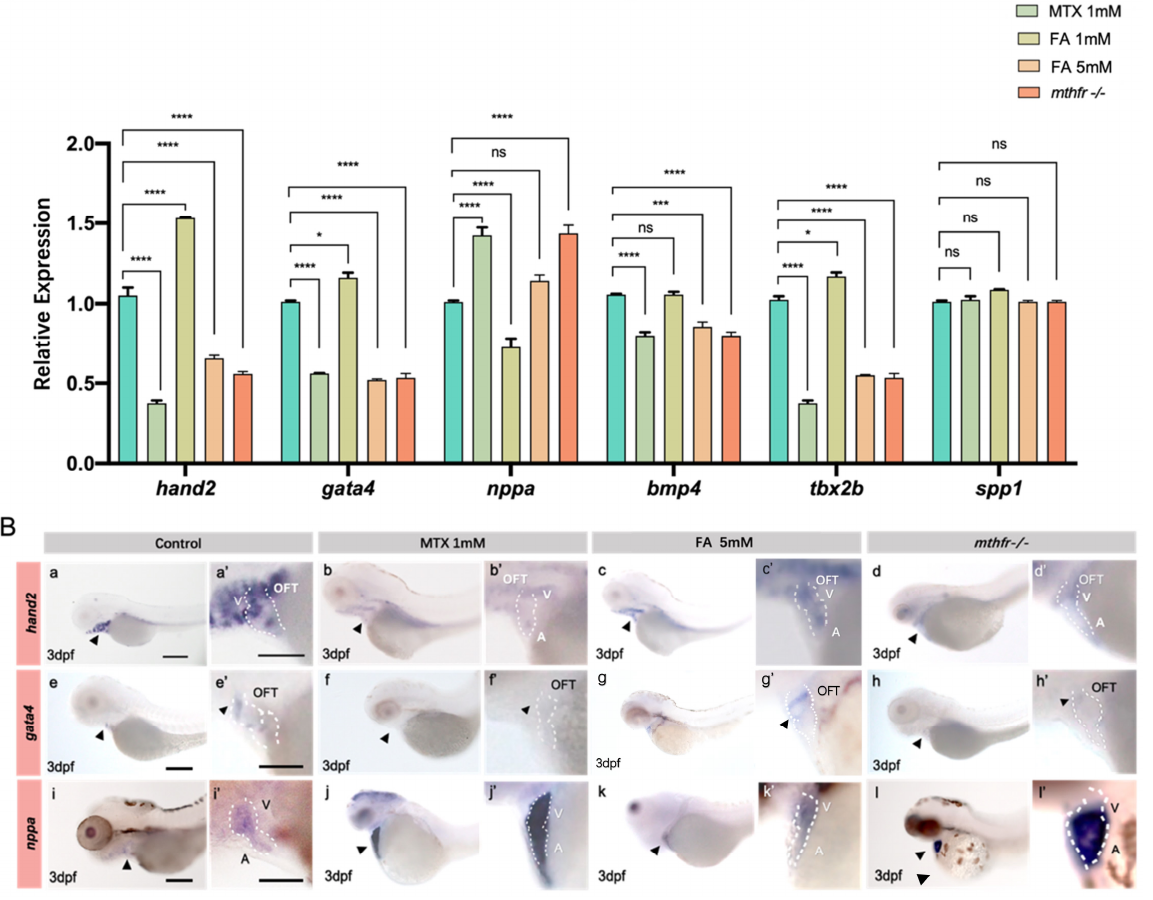
Figure 5. Abnormal folate metabolism results in changes of zebrafish embryo heart development gene expression. ( A ) Results of qPCR for hand2, nkx2.5, gata4, bmp4, tbx2b, spp1, hoxb1a, nppa in the embryonic heart of zebrafish in each group. (Student t -test, * p < 0.05, *** p < 0.001, **** p < 0.0001, ns: no statistical difference.) ( B ) In situ hybridization showed the expression of hand2 , gata4 , nppa in different groups of 3 dpf zebrafish embryonic hearts. ( a – d‘ ) is the in situ expression of the hand2 gene at different exposure concentrations, ( e – h‘ ) is the in situ expression of the gata4 gene at different exposure concentrations, ( i – l‘ ) is the in situ expression of the nppa gene at different exposure concentrations. A: atrium V: ventricle OFT: outflow tract. n = 3. Scale bars: 200 µ